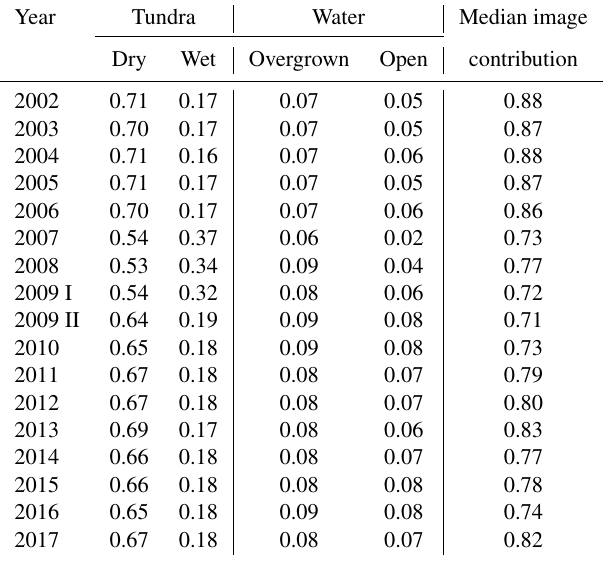
Table 6. Normalized mean contributions of the surface classes de- fined by Muster et al. (2012) to the eddy covariance footprint. Val- ues were averaged over each subperiod and normalized to sum up to 1. Additionally, the average non-normalized sum of all surface class contributions is given as the column “median image contribution”. These values indicate how sufficient the classified area is to describe the EC footprint. Non-normalized half-hourly contributions of the single classes are given in the provided data